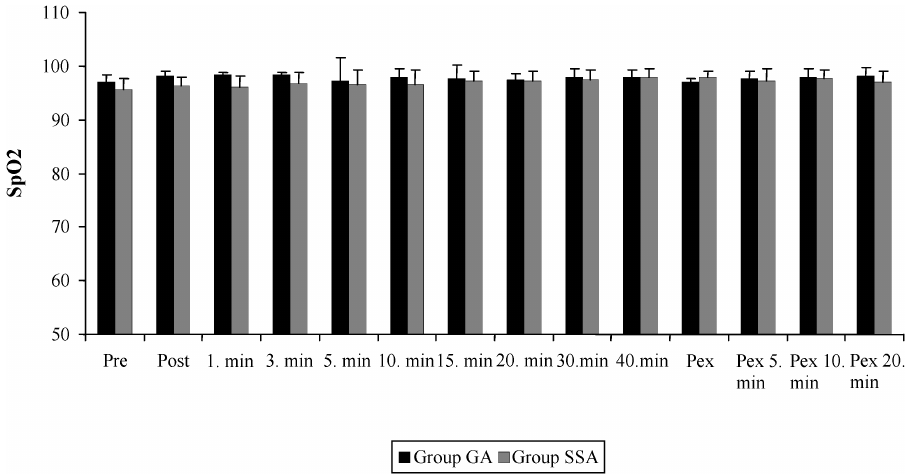
Figure 3 - Distribution of SpO 2 over time. Pre: preinduction, Post:postinduction, Pex: